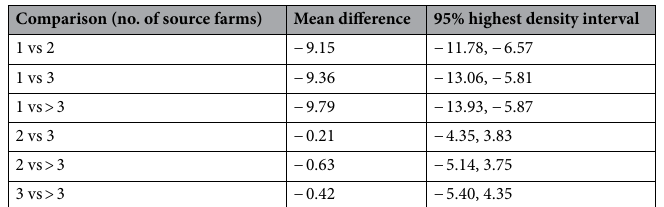
Table 3. Summary of comparisons of the effect of the number of pig batch sources on the counts of respiratory conditions recorded at slaughter.